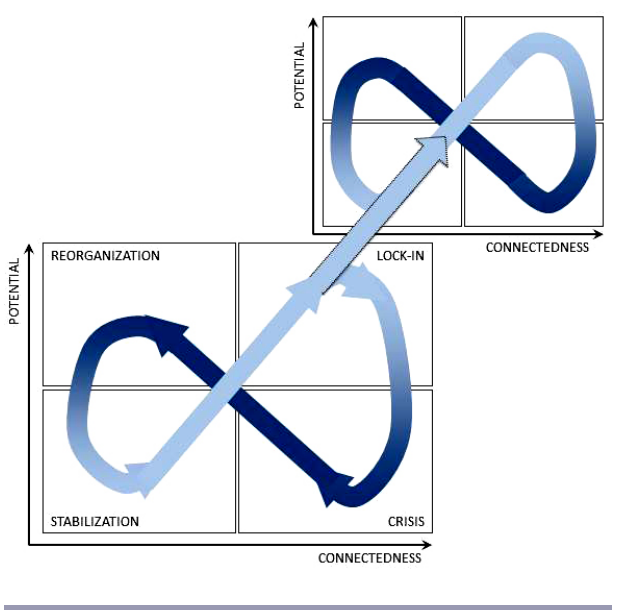
Fig. 1. The adaptive cycle as a frame for understanding resilient and transformative adaptation . The adaptive cycle provides a means of situating a case within recognized phases of adaptation: lock-in, crisis, reorganization, and stabilization. This conceptualization of adaptation also enables the distinction to be drawn between a resilient and a transformed system: a system may maintain resilience by cycling within the boundary of the system’s existing potential or functional purpose through structural changes, as represented by the bottom trajectory; or a system may transform by shifting to operate within a new range, defined by a new system potential and represented by the top trajectory. (Source: adapted from Gunderson and Holling. 2002. Panarchy: understanding transformations in human and natural systems. Island Press. Reproduced by permission of Island Press, Washington,